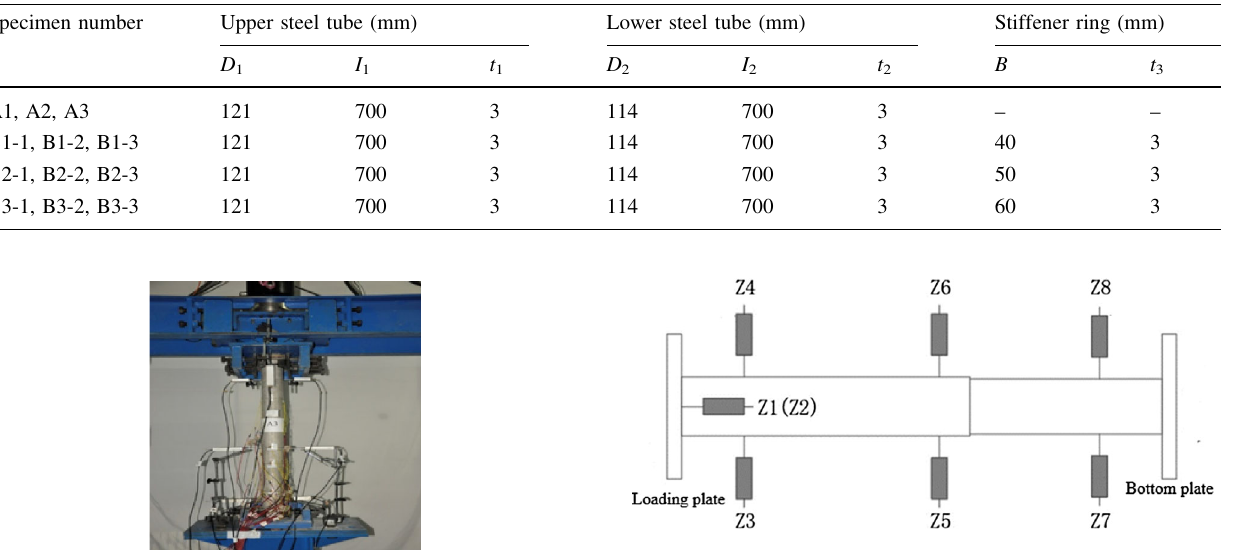
Fig. 8 Layout of displacement meters